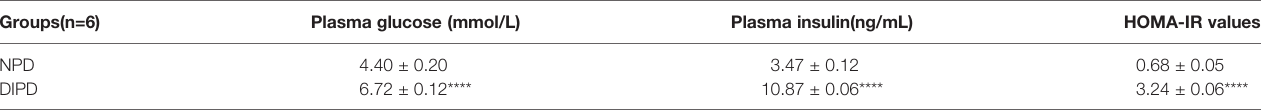
TABLE 2 | Plasma glucose, plasma insulin concentrations and HOMA-IR indices in the non-pre-diabetic (NPD) group and diet-induced pre-diabetic group (DIPD) (n=6, per group).